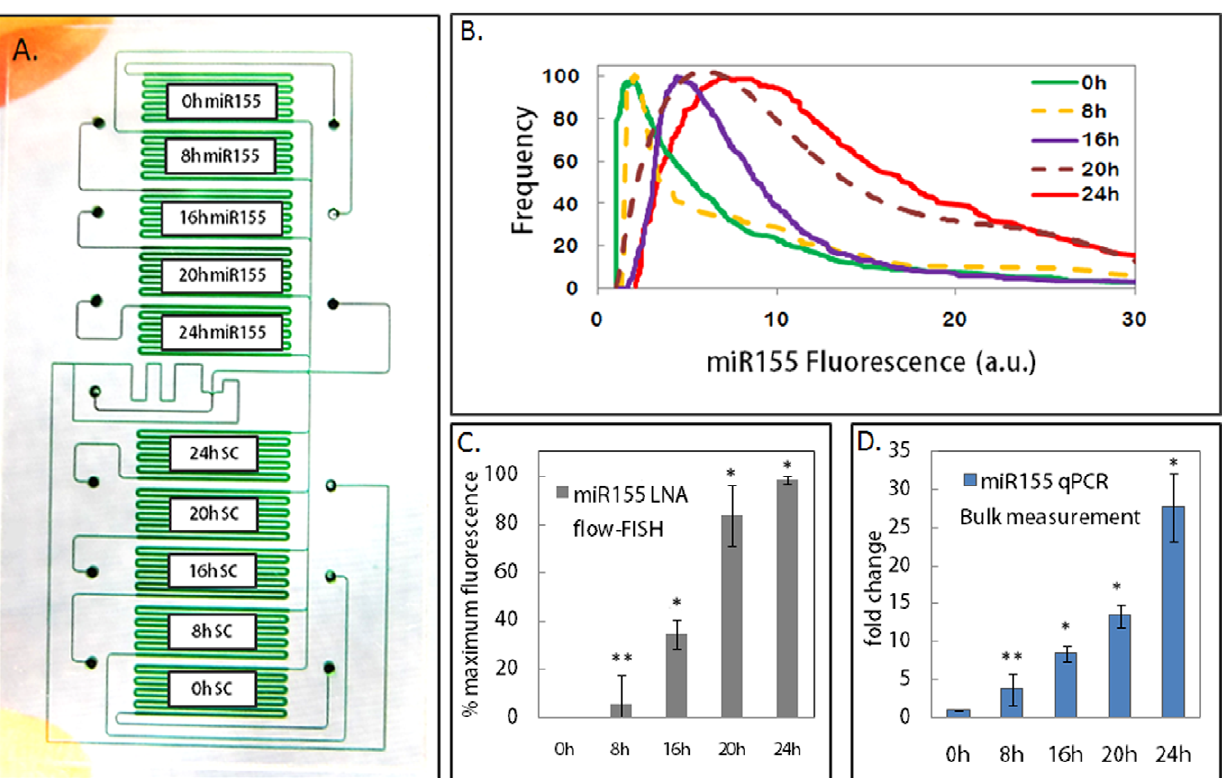
Figure 2. LNA Flow-FISH detection of miR155 in Jurkat cells activated by PMA and Ionomycin. Jurkat cells stimulated with PMA and Ionomycin for 0, 8, 16, 20, and 24 h were loaded in duplicate into the 10-chamber chip as shown in A. The top 5 chambers were hybridized with miR155 probe, whereas the bottom 5 chambers were hybridized to scrambled probe for negative control. B. overlay of miR155 fluorescence histograms measured by LNA flow-FISH. C. miR155 median fluorescence normalized as a percentage of the maximum fluorescence, showing significant increase from 0 h at 16, 20, and 24 h stimulation. (* p , 0.01) The increase at 8 h was not statistically significant (** p . 0.01). D. RT-qPCR of miR155 fold changes in Jurkat cells treated with PMA and Ionomycin, also showing significant miR155 increase starting at 16 h stimulation, but not at